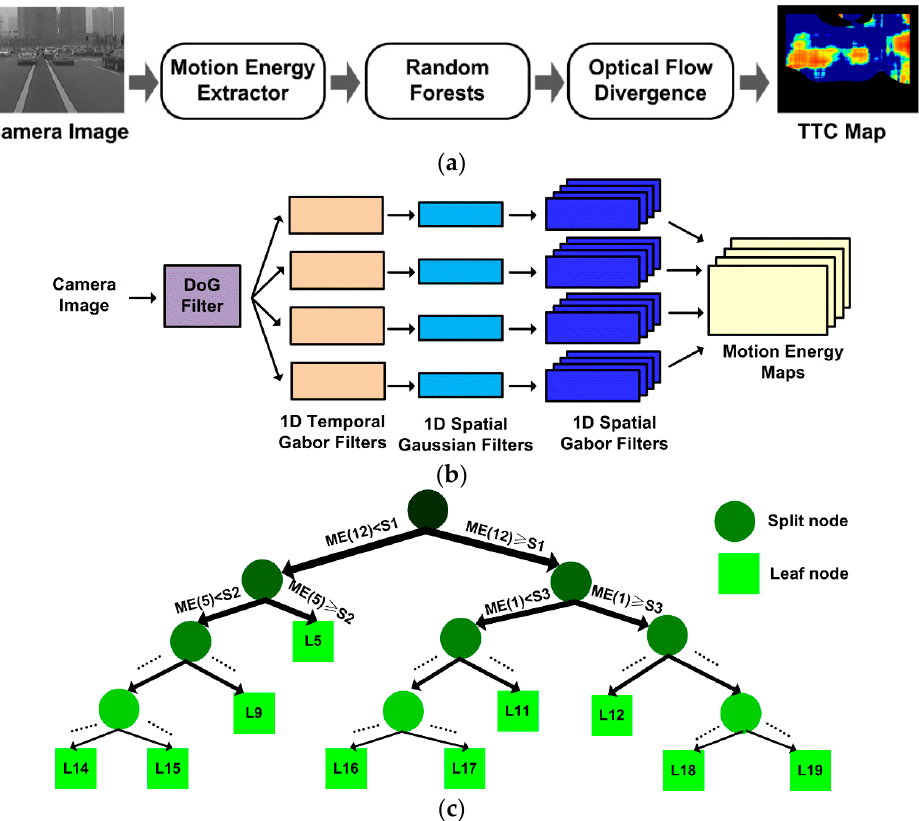
Figure 1. The proposed hardware-friendly TTC estimation algorithm based on optical flow. ( a ) Algorithm flow overview. ( b ) Spatiotemporal filters for motion energy extraction. ( c ) The structure of a trained regression tree in the random forests.